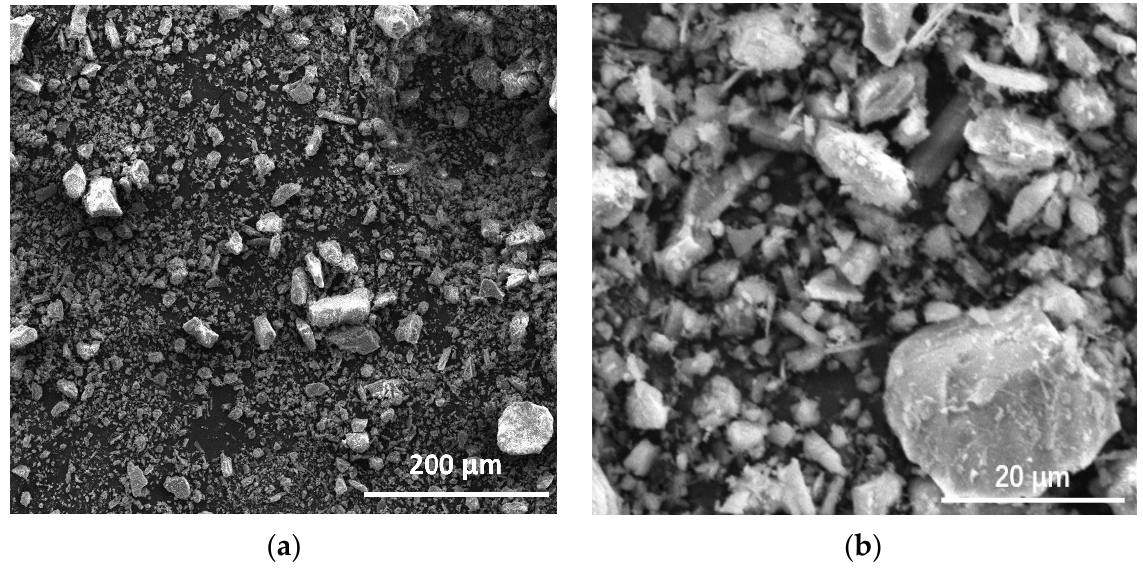
Figure 2. SEM images of copper-zinc tailing powder at low magnification ( a ), and at high magnification ( b ).